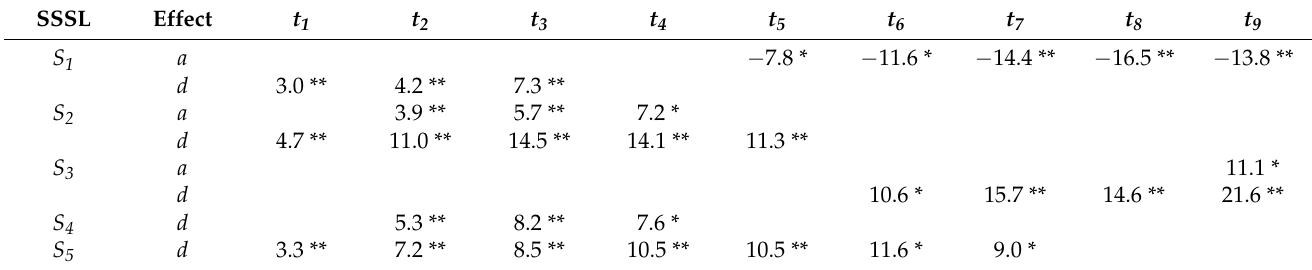
Table 2. Additive ( a ) and dominant ( d ) effects of SSSLs on the leaf numbers in various developmental stages. SSSL is an abbreviation of single-segment substitution line. S i represents the i th SSSL. t i indicates the i th stage of the measurement. “–” indicates descending leaf numbers due to alleles from the donors. * and ** show significance at the levels of the 0.05 and 0.01 probabilities,